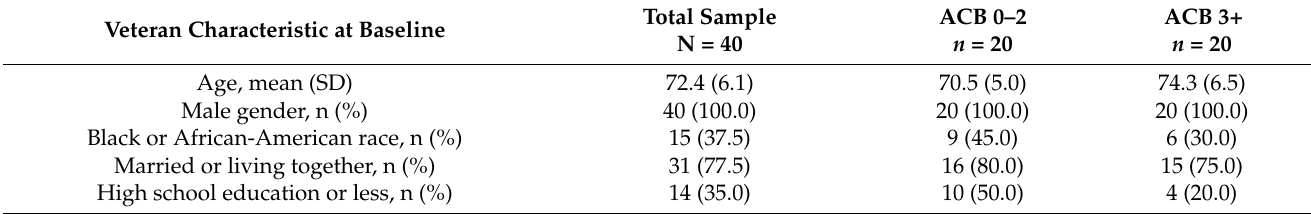
Table 1. Baseline patient characteristics and clinical measures by total anticholinergic cognitive burden